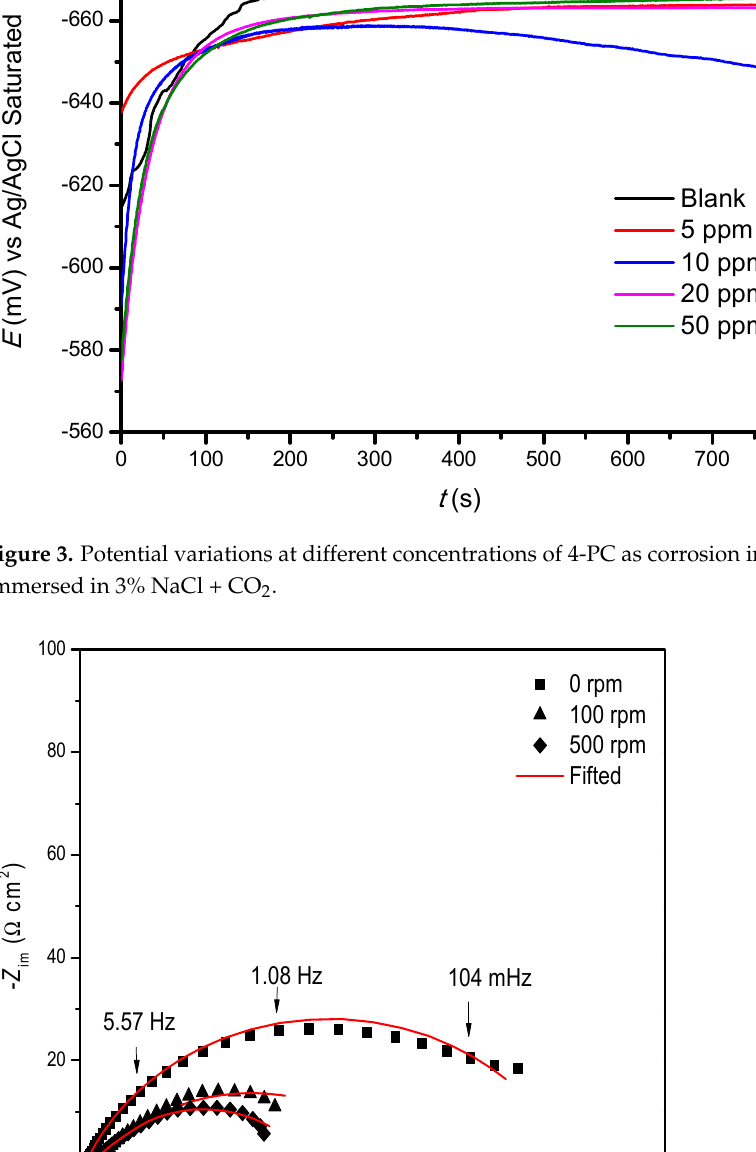
Figure 3. Potential variations at different concentrations of 4-PC as corrosion inhibitors in 1018 steel immersed in 3% NaCl + CO 2.